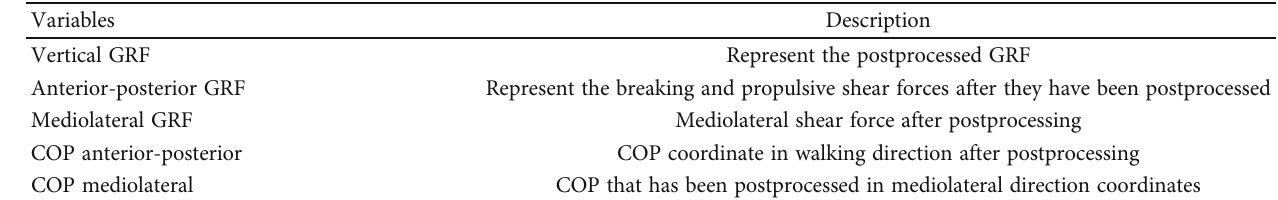
Table 2: Description of postprocessed GaitRec